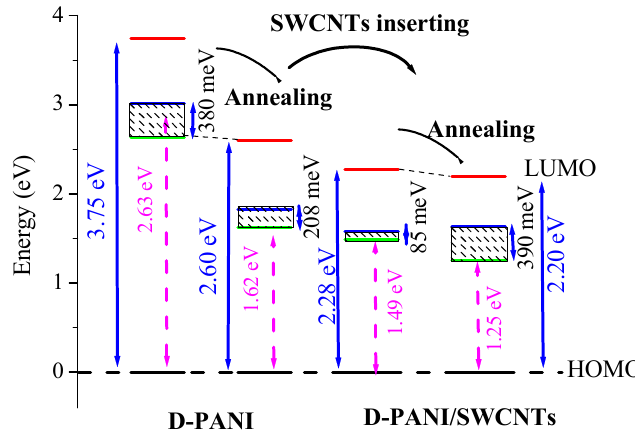
Figure 21. Change in optical parameters under doping and annealing.